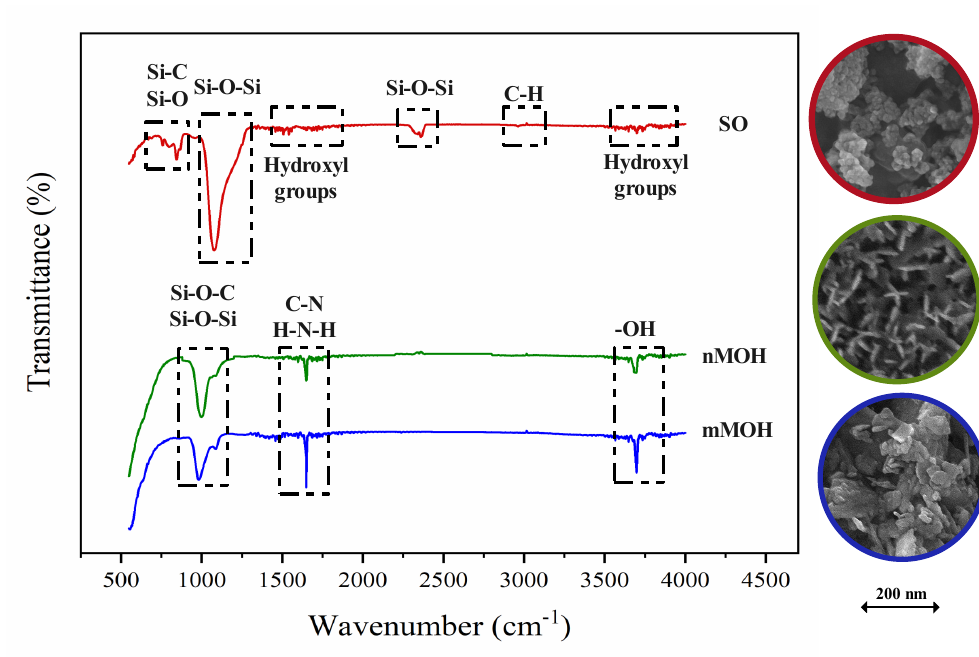
Figure 2. FESEM and FTIR analysis of fillers. While the mMOH powder was had no morphology, nMOH and SO were observed with a nanoplate and nanospherical morphology,